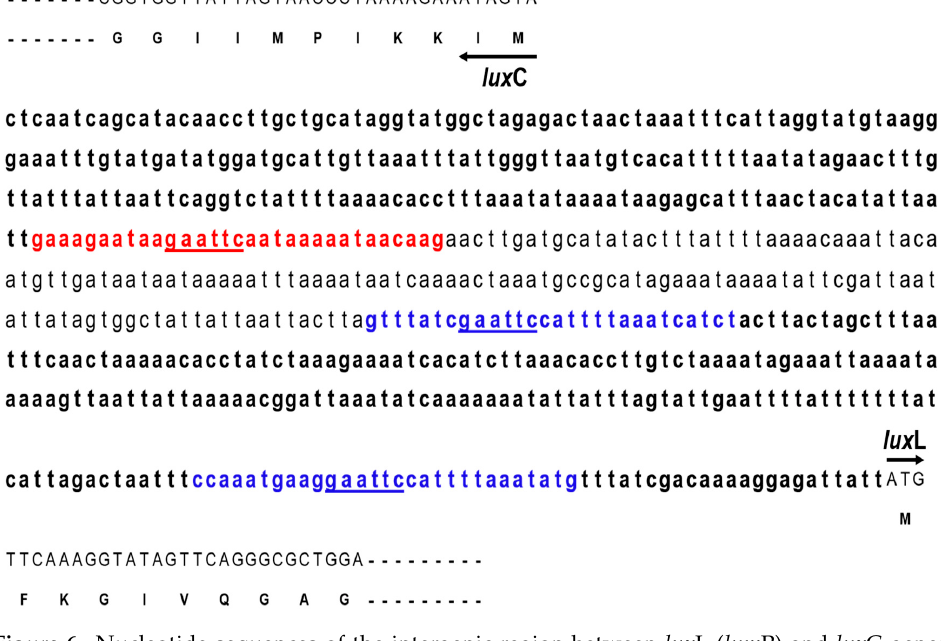
Figure 6. Nucleotide sequences of the intergenic region between lux L ( lum P) and lux C genes of P. phosphoreum . PCR primer binding sequences of the lux L and lux C promoters are shown in blue and red colors, respectively. Restriction sites of Eco RI (GAATTC) are underlined. The lux C gene is transcribed by the complementary nucleotide sequences. The nucleotide sequence (accession number L21989) was reported in the author’s previous paper [14].